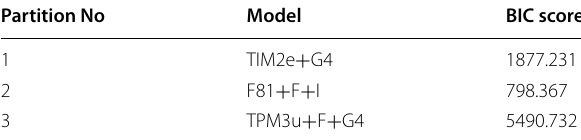
Table 2 Substitution model recommended for each